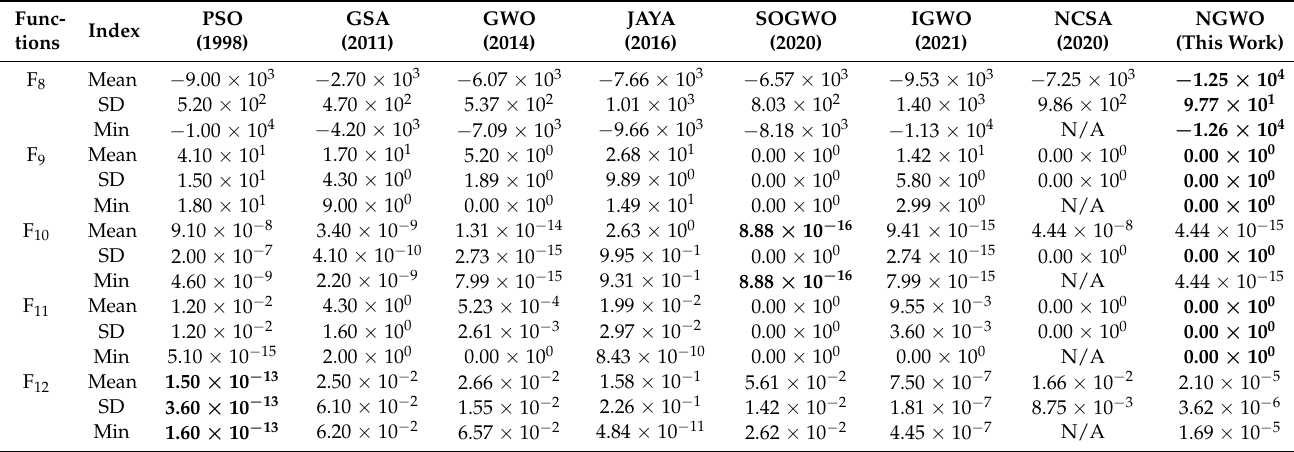
Table 4. Results of the compared algorithms for multi-modal benchmarks